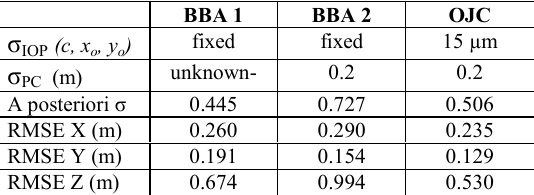
Table 11. Results for aerial images of band 23 with IOPs of band 15 from terrestrial calibration: a posteriori sigma and RMSE in the check points coordinates.